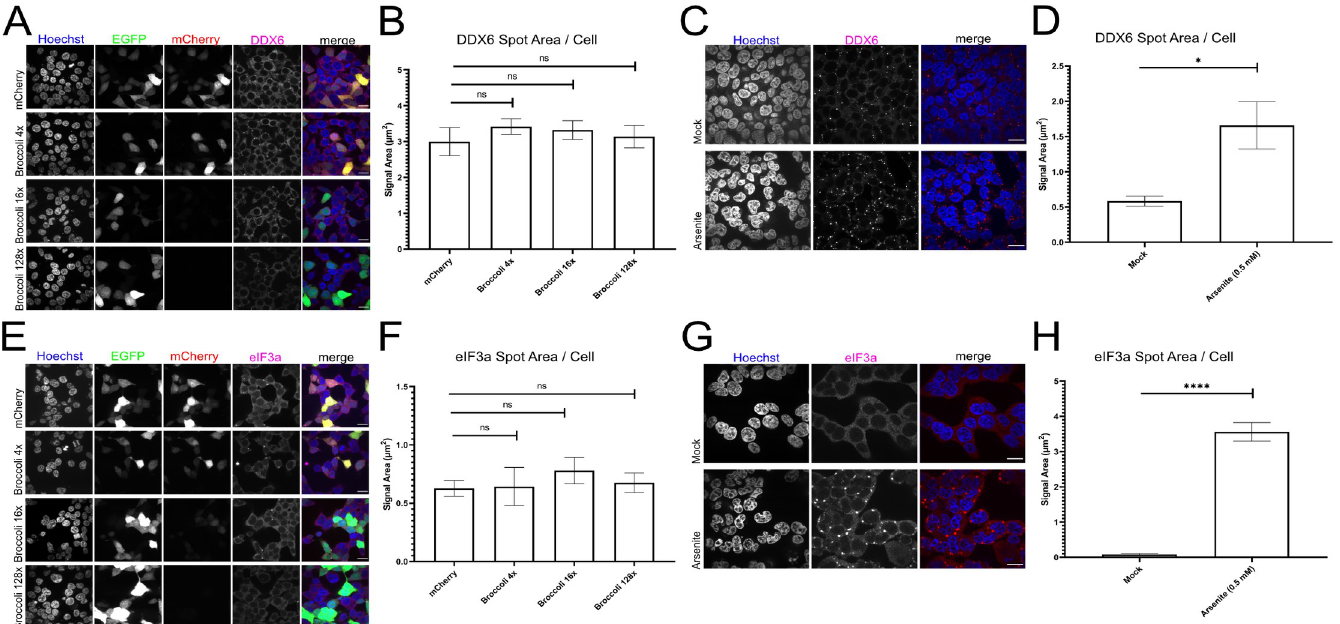
Fig 3. Broccoli concatamers do not induce p-bodies nor stress granules. (A) HEK293T cells were transfected with mCherry, 4x, 16x or 128x Broccoli as well as pEGFP-C1 as transfection control. After 24 hours, the cells were fixed and IF stained for DDX6. (B) The area of DDX6 positive spots in HEK293T cells from A was measured. No significant difference between the Broccoli versions was detectable. (3 Replicates; N mCherry = 3776, N 4xBroccoli = 3552, N 16xBroccoli = 3710, N 128xBroccoli = 5312) (C) HEK293T cells were treated/mock-treated with 0.5 mM Sodium Arsenite for 1h to induce cell stress. Afterwards, the cells were fixed and stained for DDX6. (D) The area of DDX6-positive spots in HEK293T cells from (C) was measured. The difference between the mock treatment and the Arsenite treatment is statistically significant with p = 0.0348. (3 Replicates; N Arsenite = 9796, N Mock = 12526) (E) HEK293T cells were transfected and fixed for IF as described in A. The cells were afterwards IF stained for eIF3a. (F) The area of eIF3a positive spots in cells from E was measured. No significant difference between the Broccoli versions was detectable. (4 Replicates; N mCherry = 6030, N 4xBroccoli = 4674, N 16xBroccoli = 5860, N 128xBroccoli = 6992) (G) HEK293T cells were treated with Sodium Arsenite as described in (C). After fixation the cells were IF stained for eIF3a. (H) The area of eIF3a positive spots in cells from G was measured. The difference between the mock treatment and the Arsenite treatment is statistically significant with p < 0.0001 (3 Replicates; N Arsenite = 10704, N Mock = 8200). All error bars show the standard error of the mean and all scale bars represent 20 μ m.